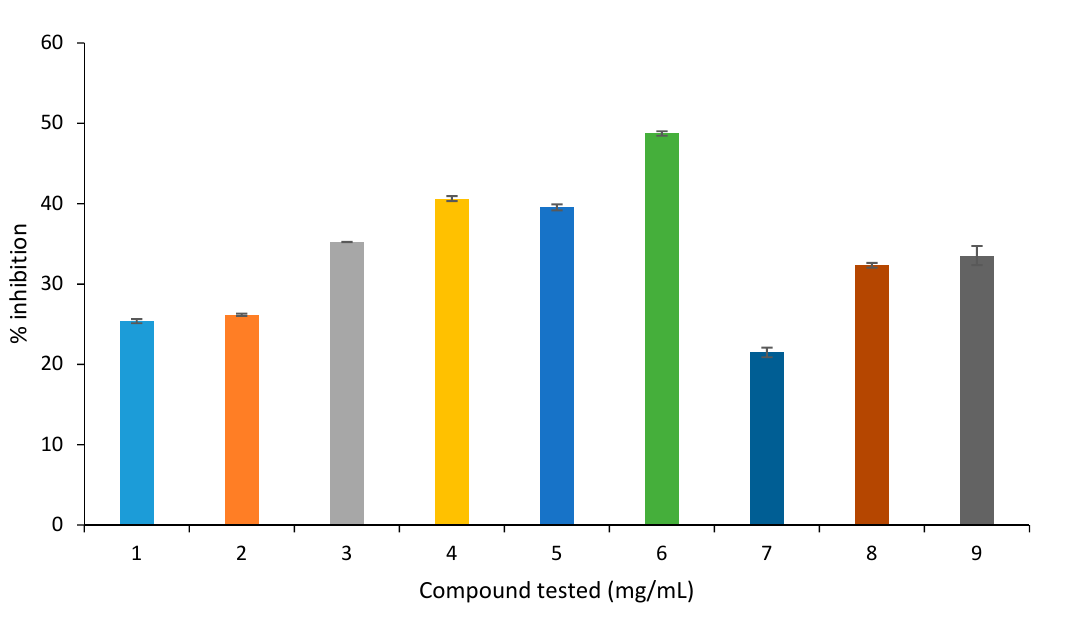
Figure 5. Inhibition of protein cross-link formation in the BSA-MGO assay (1 = eugenol, 2 = caryophyllene, 3 = caryophyllene oxide, 4 = α -humulene, 5 = juglone, 6 = 2-phenylethylisothiocyanate, 7 = quercetin, 8 = quercitrin, 9 = apigenin).